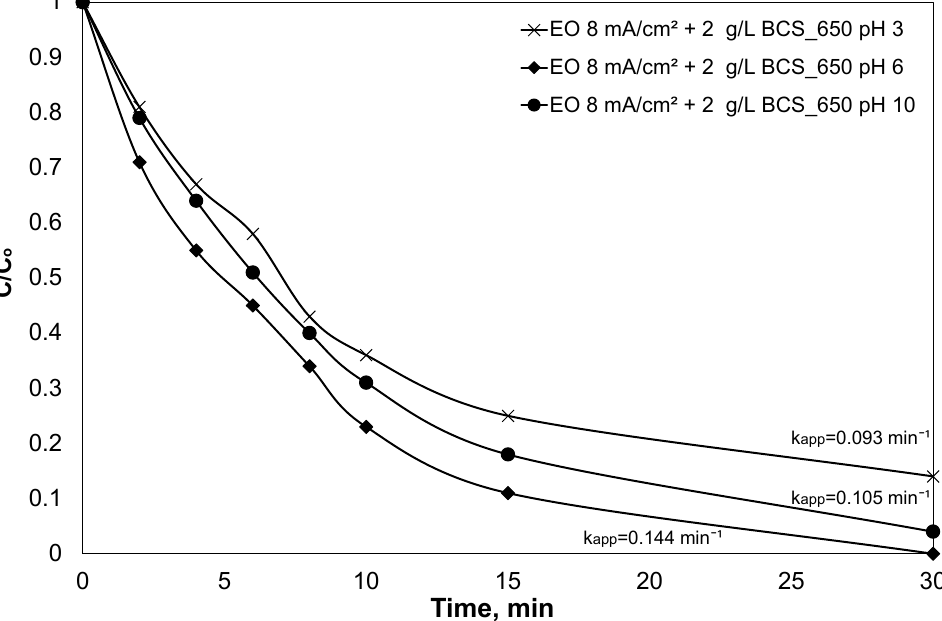
Figure 6. Effect of pH on the degradation of SMX in the combined 3D process. Conditions: [SMX]° = 500 μ g/L, [BCS_650] = 2 g/L, [Na 2 SO 4 ] = 0.1 M, j = 8 mA/cm 2 , ultrapure water.